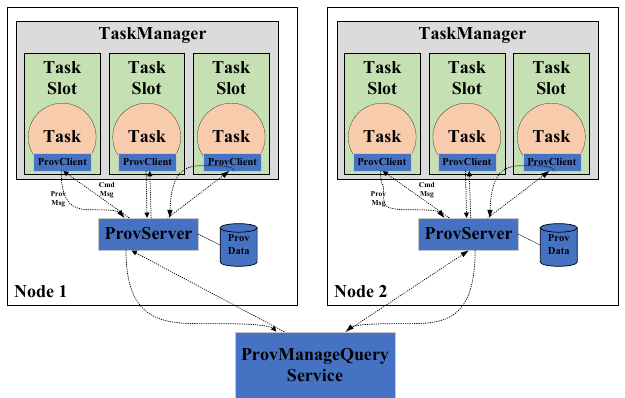
Figure 9. Demonstration for provenance management system working in with one Flink application in distributed mode.